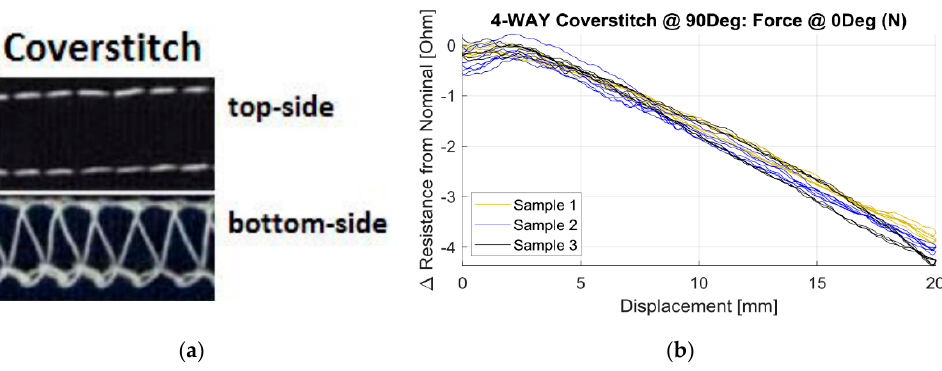
Figure 19. ( a ) Coverstitch structure and ( b ) resistance versus displacement curve [37].